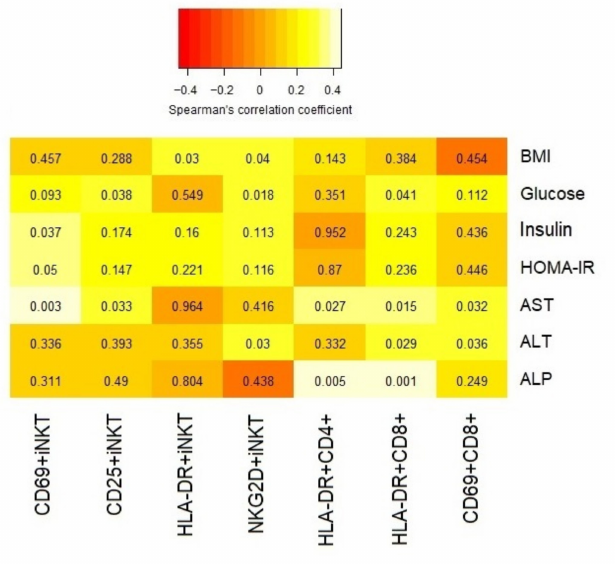
Figure 6. Spearman’s correlations between the activation profiles of iNKT cells, CD4+ and CD8+ T lymphocytes, and anthropometric/biochemical variables for the whole population (non-alcoholic fatty liver disease (NAFLD), drug-induced liver injury (DILI), and healthy controls) ( p -value in each